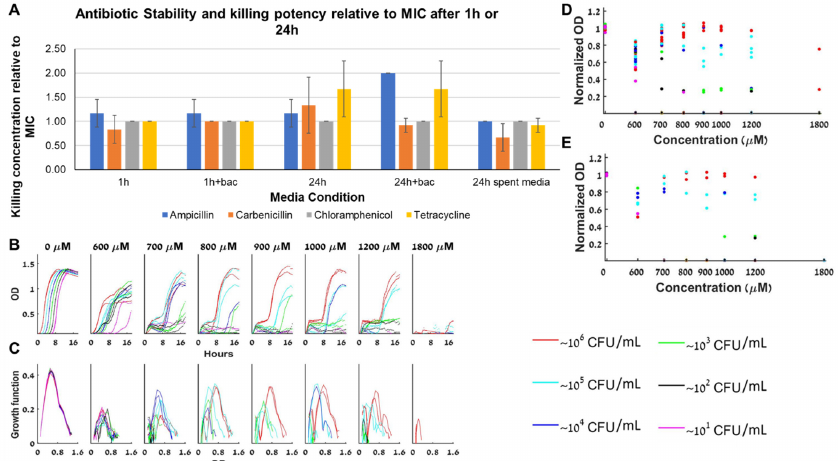
Figure 7. Antibiotic stability. ( A ) Minimal inhibitory concentration of the antibiotic relative to the MIC as a function of several media conditions (incubation with or without antibiotics and bacteria as indicated). ( B ) Different loads of bacteria grown with oxacillin have a similar growth slope in the exponential growth phase at almost all A’s (except for loads that fail to grow altogether). ( C ) The specific growth function of the different loads in oxacillin changes with the loads and with A, with no obvious trend with respect to A. In particular, the peak of the function remains essentially constant at different oxacillin concentrations. ( D ) The maximal capacity at all oxacillin concentrations is always similar, and does not decline as A becomes bigger, although different loads reach different maximal capacities in each antibiotic concentration. ( E ) The maximal capacities of different loads grown in oxacillin from 6 different experiments. See also separate experimental results in Figure